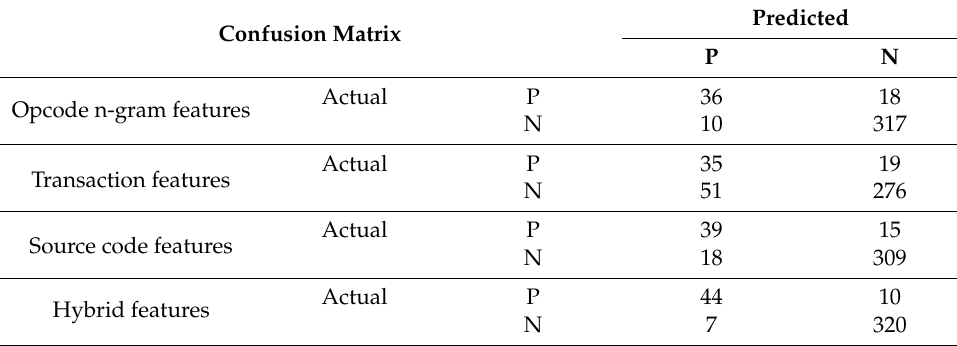
Figure 9. Performance of the proposed feature sets. Table 7. Confusion matrix of the proposed method on our